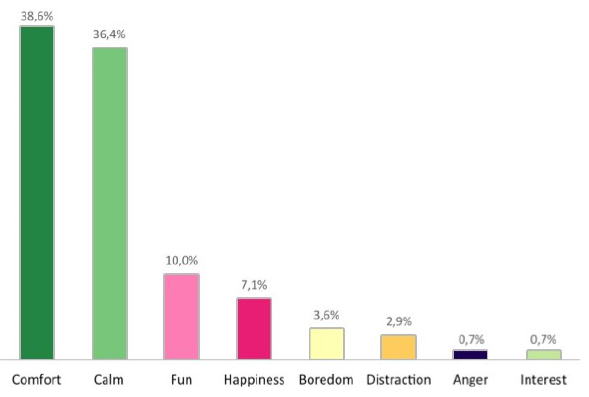
through the app’s questionnaire (question 5/section 1) by means of an open question – see Figure 5.